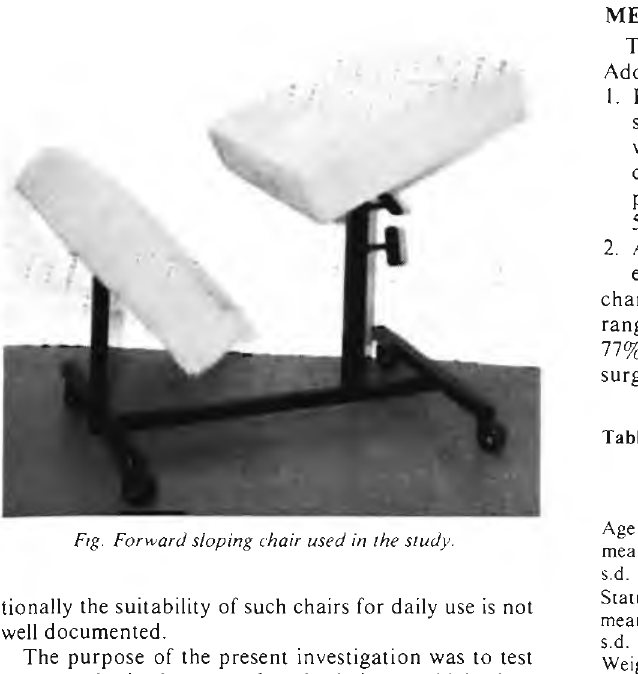
Fig. Forward sloping chair used in the study.